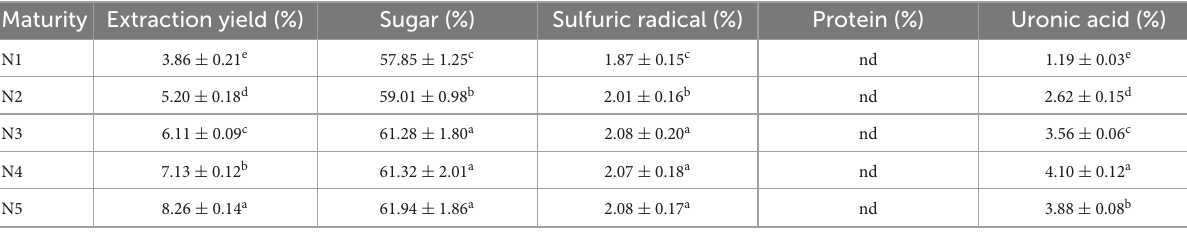
TABLE 1 Chemical composition and extraction yield of Noni polysaccharide at different maturity stages. Maturity Extraction yield (%) Sugar (%) Sulfuric radical (%) Protein (%) Uronic acid